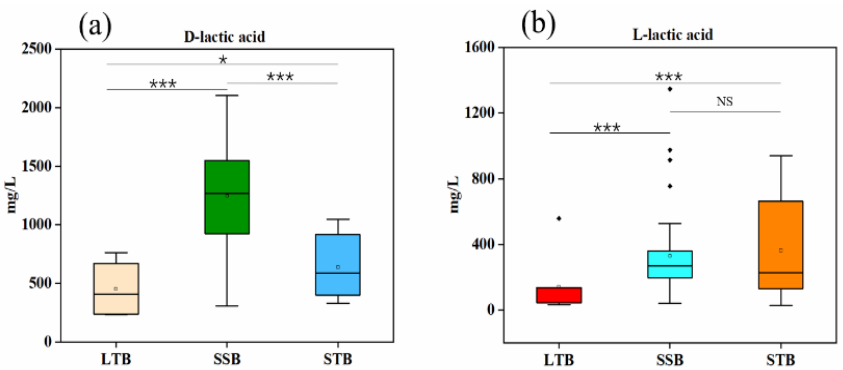
Figure 4. ( a , b ) Box plots of D-lactic acid and L-lactic acid contents in three aromatic Baijiu (SSB, STB, and LTB). t-test: NS (not significant, p > 0.05); *: 0.01 < p < 0.05; **: 0.001 < p < 0.01; and ***: p < 0.001.